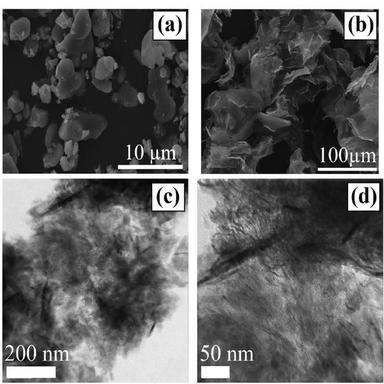
FE-SEM images from the (a) TiB2 and (b) graphene particles. (c, d) TEM images from the graphene nanoplatelets.